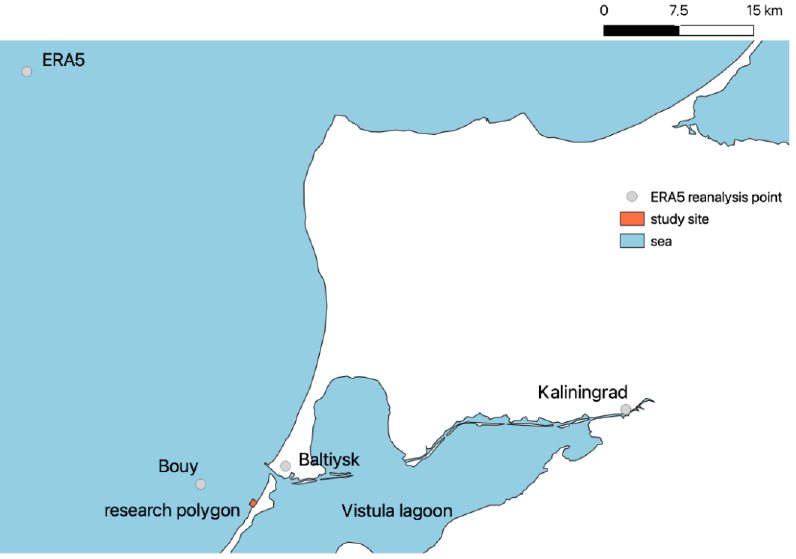
Figure 1. Study site, region of the bathymetry measurements (small pink rectangle), ERA5 point and buoy location.